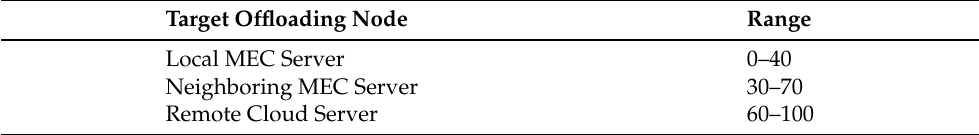
Table 4. Offloading Decisions.